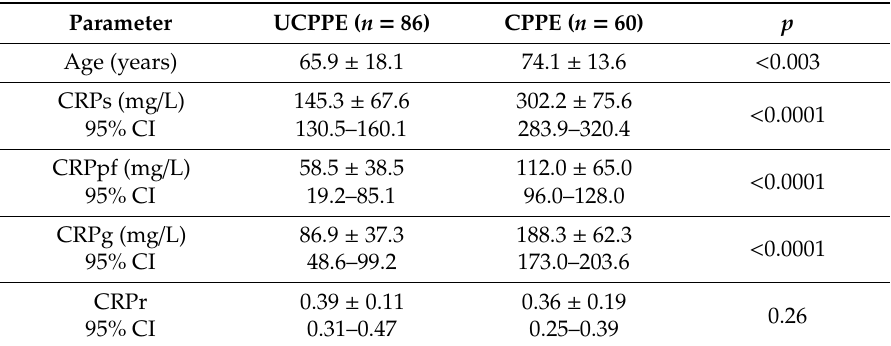
Table 1. Mean ± SD of age, and mean ± SD and 95% CI of means of levels of CRPs, CRPpf, CRPg, and CRPr of UCPPE group and CPPE group. Parameter UCPPE ( n = 86) CPPE ( n =